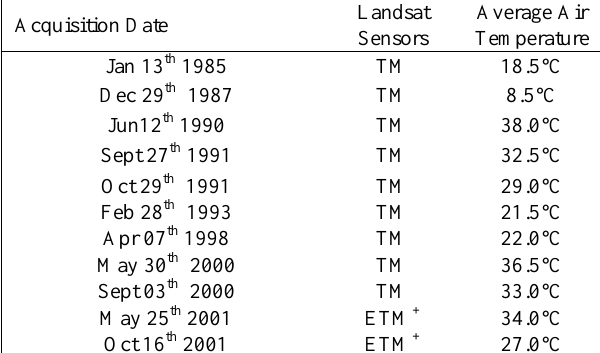
Table 2. Landsat TM and ETM+ Images for the